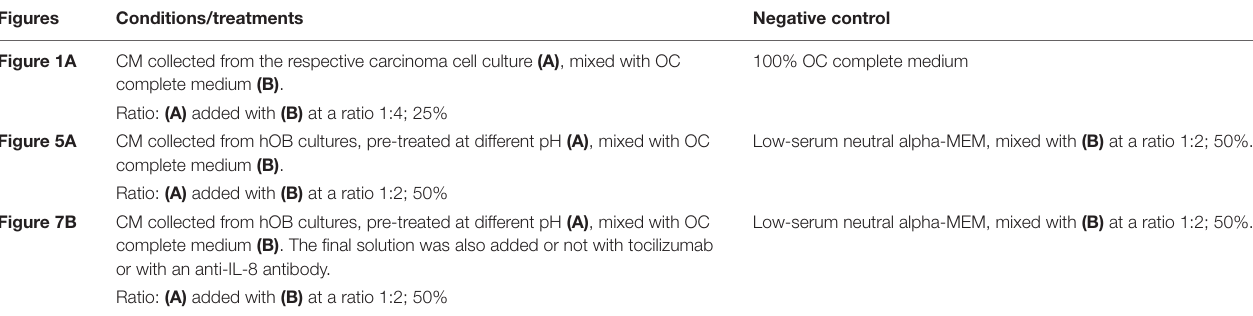
100% OC complete medium Low-serum neutral alpha-MEM, mixed with (B) at a ratio 1:2; 50%. 100% OC complete medium Low-serum neutral alpha-MEM, mixed with (b) at a ratio 1:2; 50%.